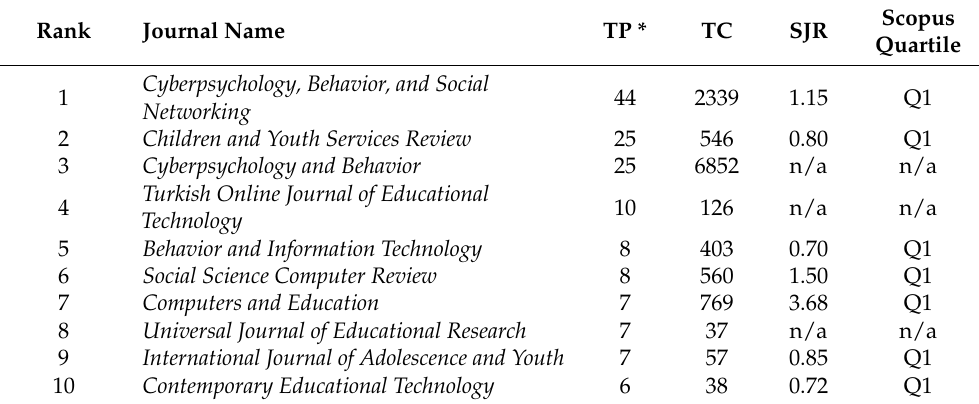
Table 3. Top 10 journals in terms of the number of publications on digital